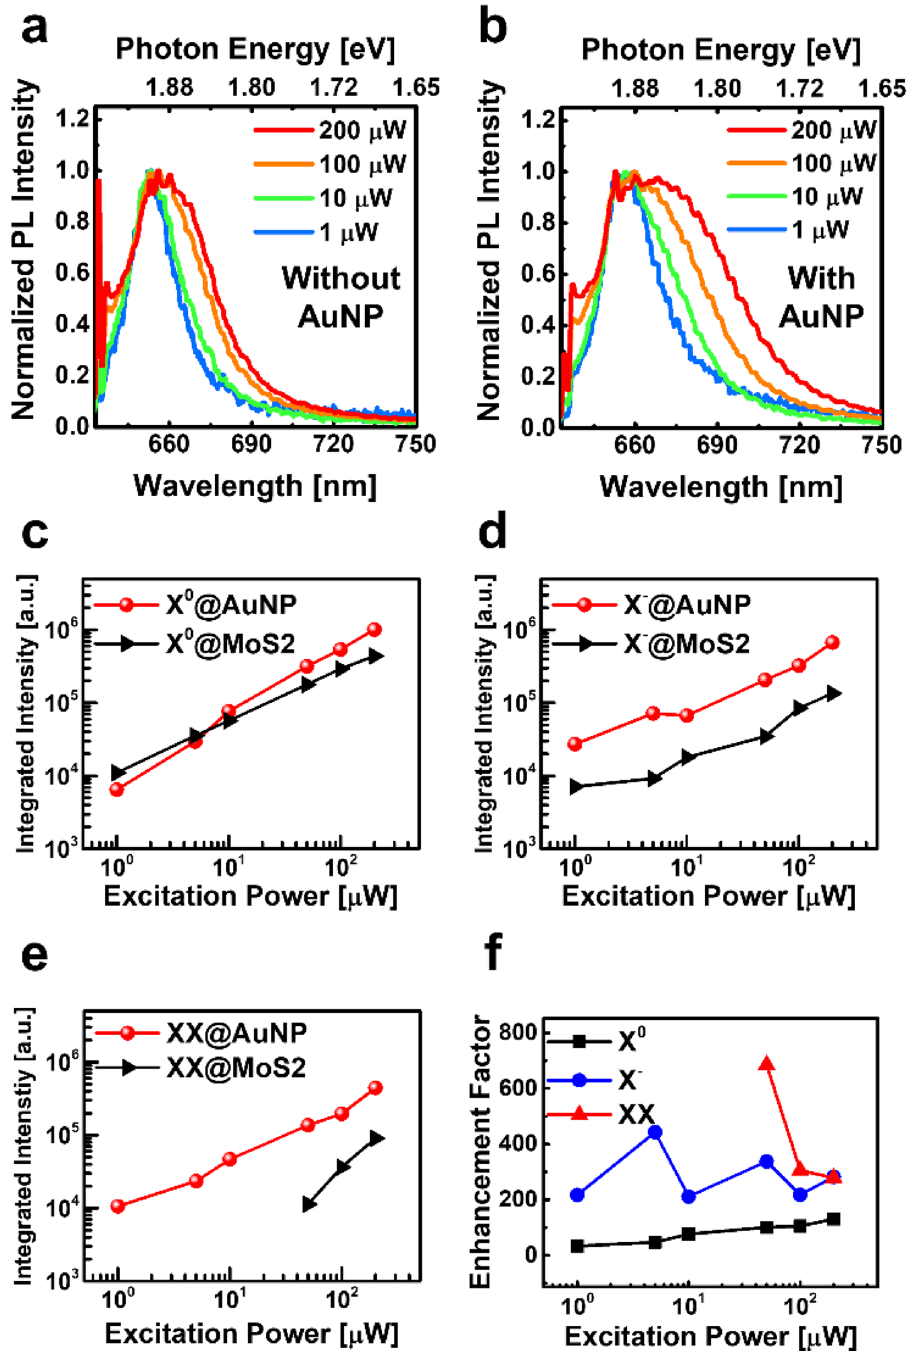
Figure 5. Fundamental power dependence normalized PL spectra and deconvolution results. Power dependence Normalized PL spectra in ( a ) the monolayer bare MoS 2 and ( b ) the MoS 2 /AuNP hybrid structure. The integrated intensity of deconvolution results for ( c ) neutral exciton (X 0 ), ( d ) trion (X – ), and ( e ) biexciton (XX), respectively. ( f ) Calculated enhancement factor of each exciton